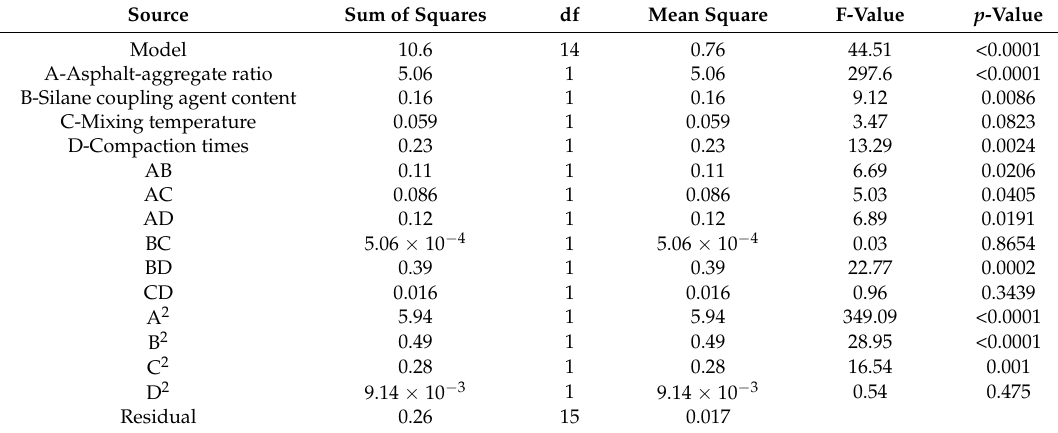
Table 7. ANOVA Analysis of − 15 ◦ C splitting strength response model.